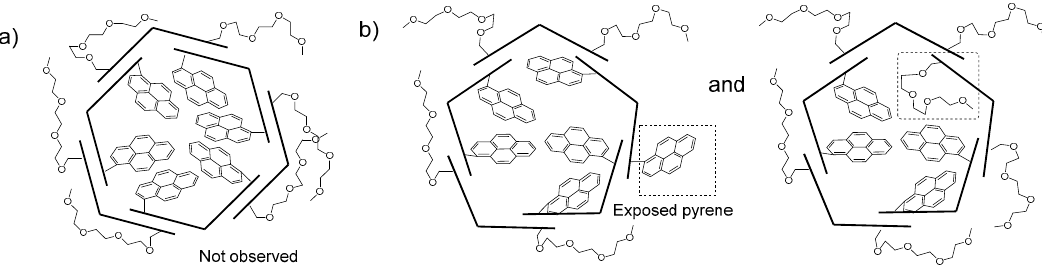
Figure 20. Five UV-vis absorption spectra normalized at 446 nm are overlaid. Original data were obtained on GPC analysis as shown in Figure 18d. At 350 nm, the five spectra of RT: 17.70, 17.80, 17.91, 18.10, and 18.18 min can be discriminated from the bottom to the top. Pyrene moiety is mainly observed in the rage of 250–350 nm. Increasing the intensities at 350 nm indicates that the ratio of the PY-GP1 component increased compared with that of PEG8-GP1 in the cyclic pentamers.